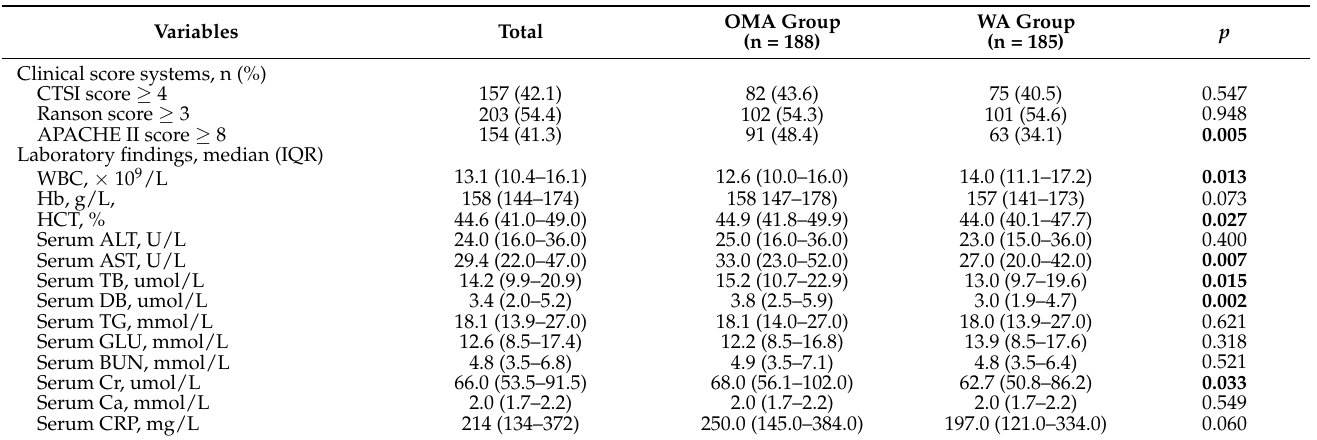
Table 2. Comparison of clinical scoring systems and laboratory findings in patients in OMA group and WA group.